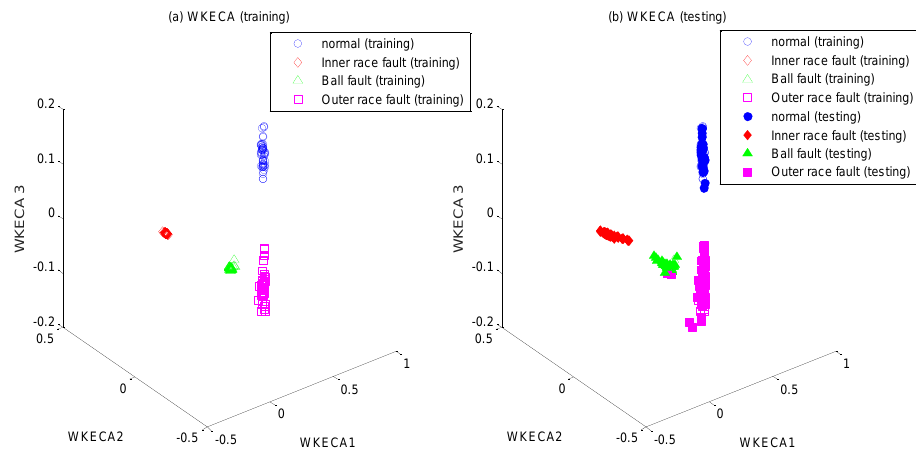
Figure 8. Feature extraction with WKECA: ( a ) training samples, ( b ) testing samples.